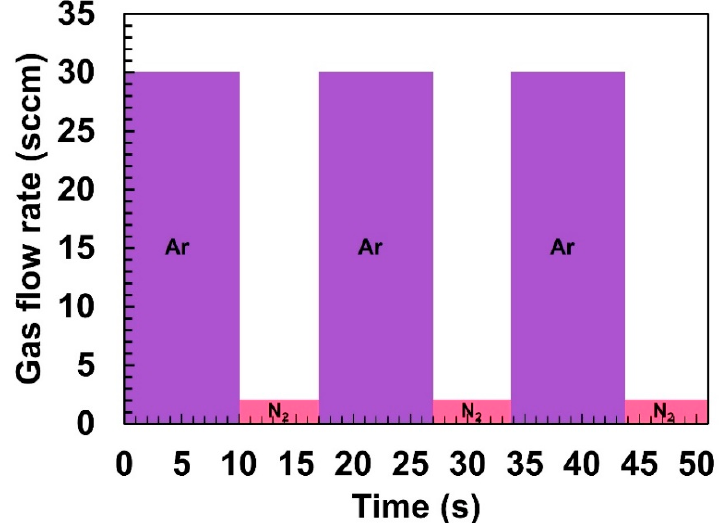
Figure 1. Schematic diagram of gas sequence during RGT RF magnetron technique by programmable mass flow controllers.